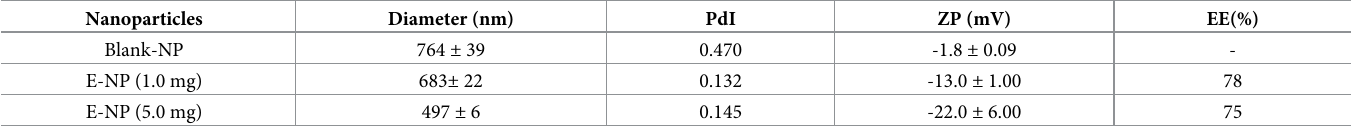
Table 1. Characterization data: Mean diameter, polydispersity index (PdI), zeta potential (ZP) and efficiency encapsulation (EE).